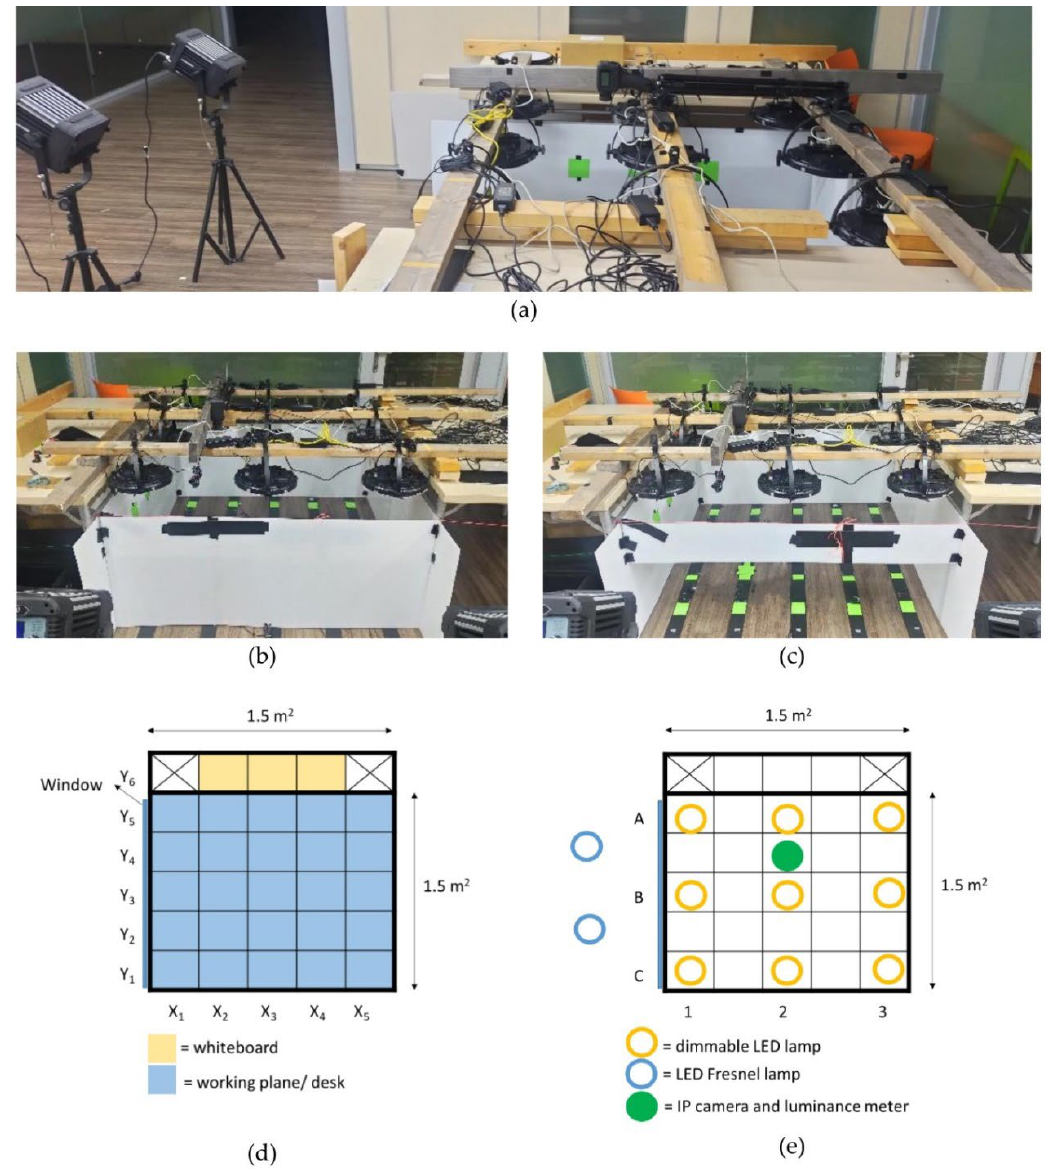
Figure 1. ( a ) The prototype is set on a 1.5 × 1.5 m 2 area; ( b ) The model for the closed room without daylight scheme; ( c ) The model for the room with a window on one side and daylight is presented; ( d ) The layout of the prototype; ( e ) The arrangement of lamps.